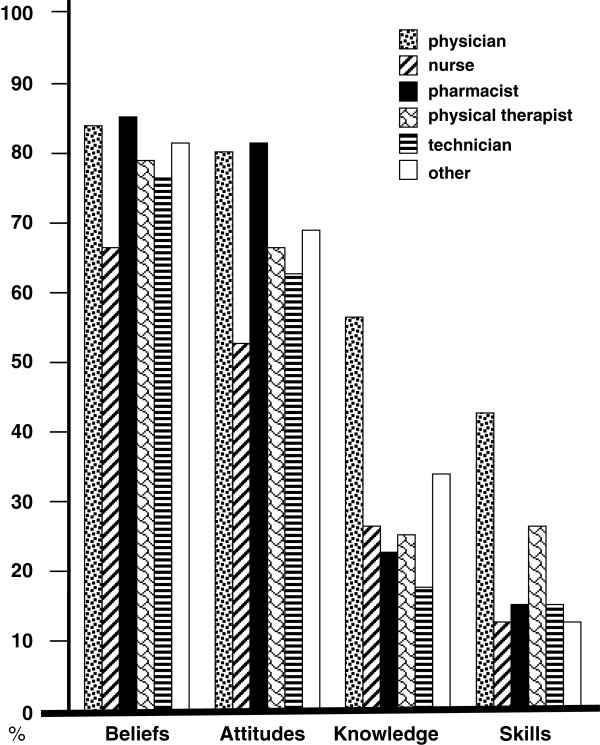
Four evidence-based practice (EBP) characteristics among 6 groups of healthcare professionals. Beliefs: EBP is important to improve patient care quality. Attitudes: I am willing to support the promotion of EBP implementation. Knowledge: I have sufficient knowledge to implement EBP principles. Skills: I possess sufficient skills to implement EBP principles.